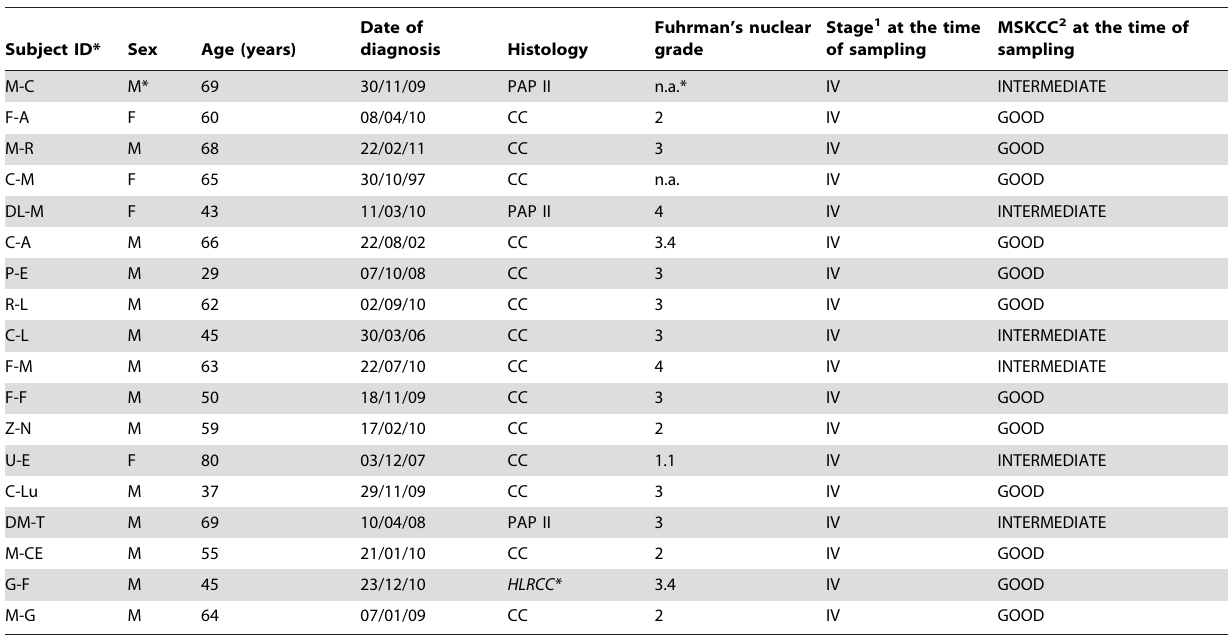
CC 2 IV GOOD 1 Stage is indicated accrding to the 2002 TNM staging system;. 2 MSKCC Motzer prognostic score for advanced kidney cancer patients; it includes 5 parameters: - Karnofsky performance status , 80%; - Haemoglobin levels , normal lower limits; - LDH serum levels . 1.5 time the normal upper limit level; - Corrected calcium . 10 mg/dL; - Absence of prior nephroctomy. If a patient meets more than 2 criteria the prognosis is POOR, if meets 1–2 criteria is INTERMEDIATE, if meets no criteria is GOOD. *Abbreviations: ID for ‘‘identity’’; M for male patients; F for female patients; PAP II for the ‘‘Papillary type II’’ histology; CC for ‘‘Clear Cell’’ histology; HLRCC for ‘‘Hereditary leyomiomatosis renal cell carcinoma’’; n.a. for ‘‘not applicable’’.